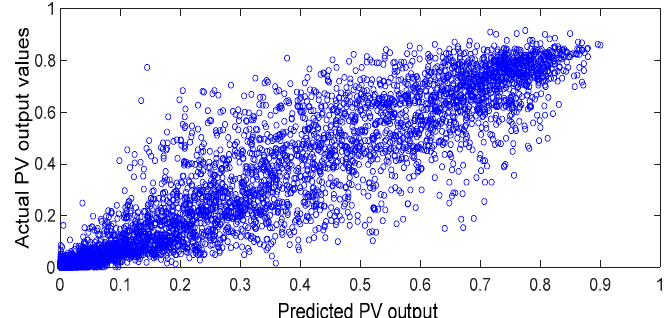
Figure 5. Scatter plot of the predicted and actual values using IMLSSVM. Table 4. Statistics of samples in each interval.